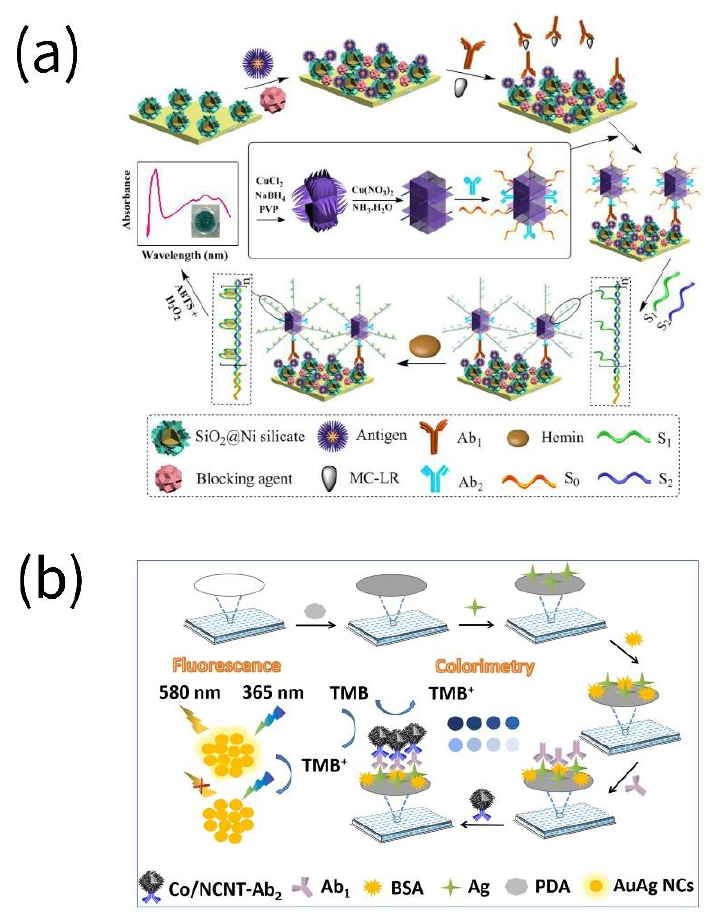
Figure 2. Assays for the detection of toxins in food by nanozymes. ( a ) Microcystin-LR (MC-LR) was detected using coupling copper hydroxide nanozyme and G-quadruplex/hemin DNAzyme (reprinted with permission from [38], Copyright 2019, American Chemical Society). ( b ) OTA was detected using ZIF-derived hollow Co/N-doped carbon nanotubes (CNTs) (reprinted with permission from [40], Copyright 2022, Elsevier).